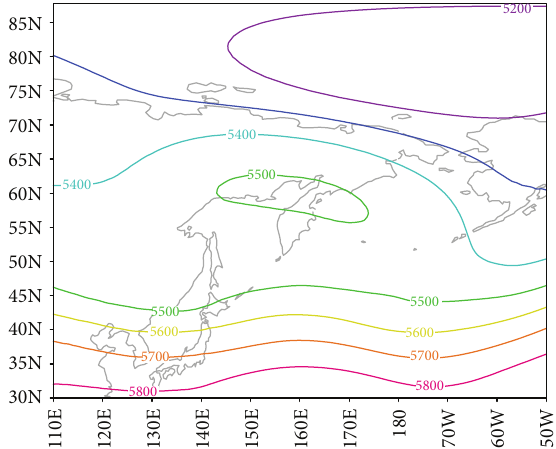
Figure 2: GEFS ensemble mean time-averaged geopotential heights for October 11–19,